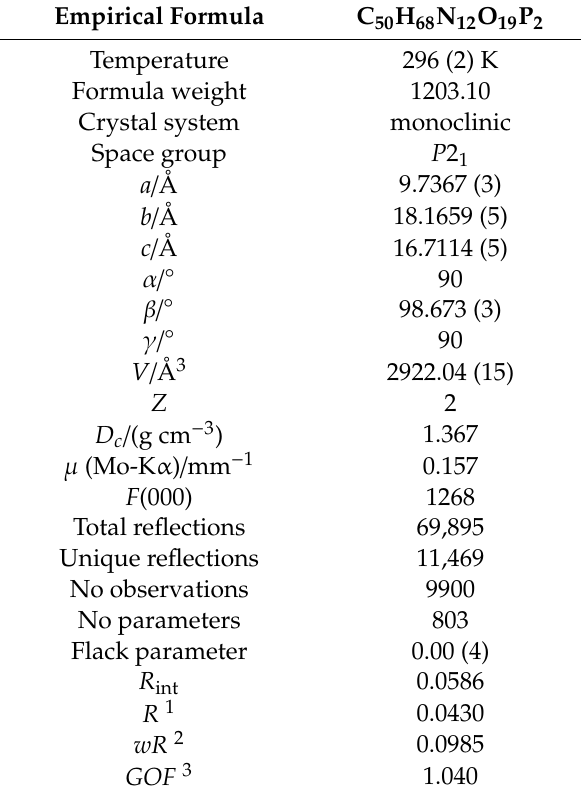
Table 1. Summary of the crystallographic data for 2